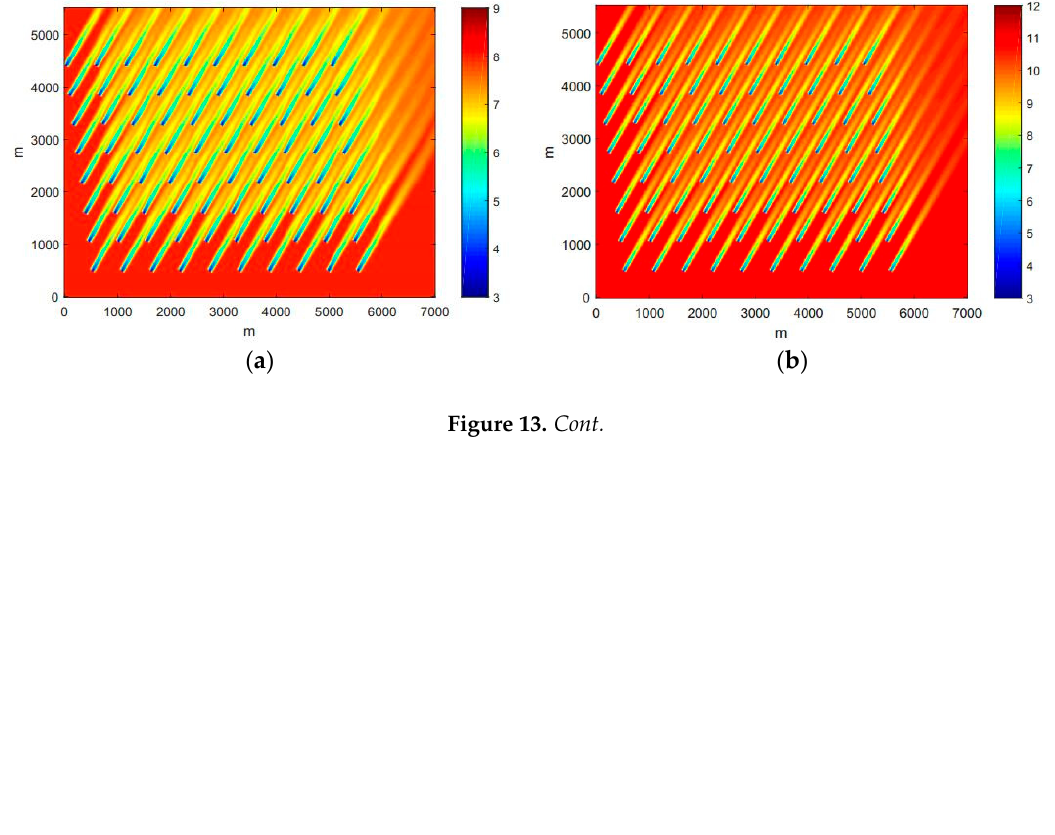
Figure 12. Wake velocity and SPL with wind turbine row.